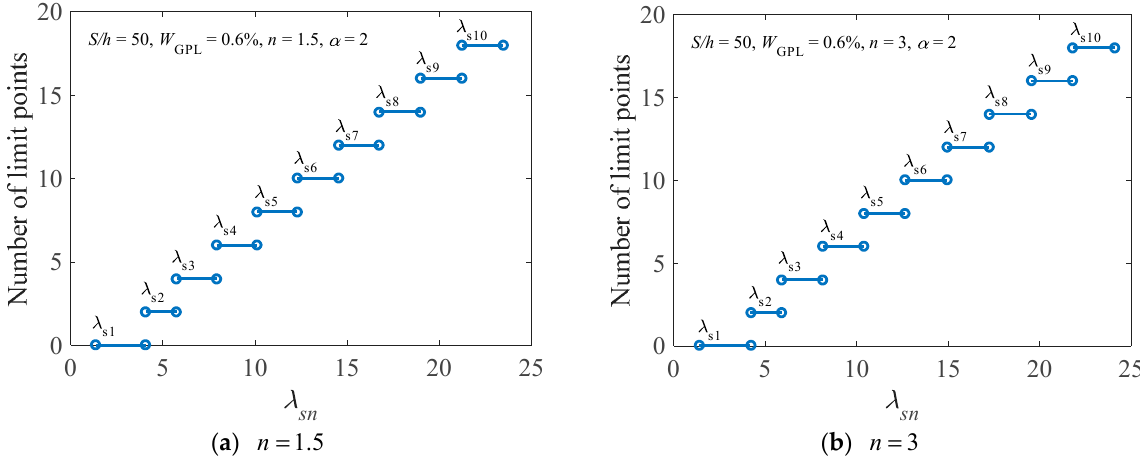
Figure 11. Number of limit points of an elastically restrained FG-GPLRC arch under different power law indices.